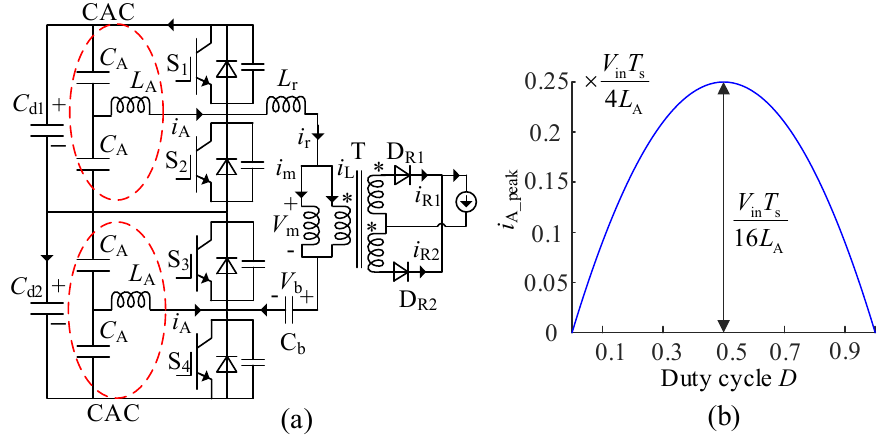
Figure 1. ( a ) ITLDC with the CAC. ( b ) Auxiliary current changes with duty cycle. Where the * represents the dotted terminal of the transformer and the circuits in the red circles are the CACs.